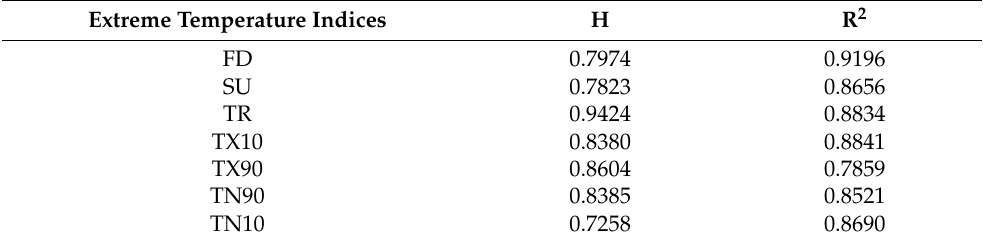
Table 2. Results of R/S analysis of extreme temperature in indices.